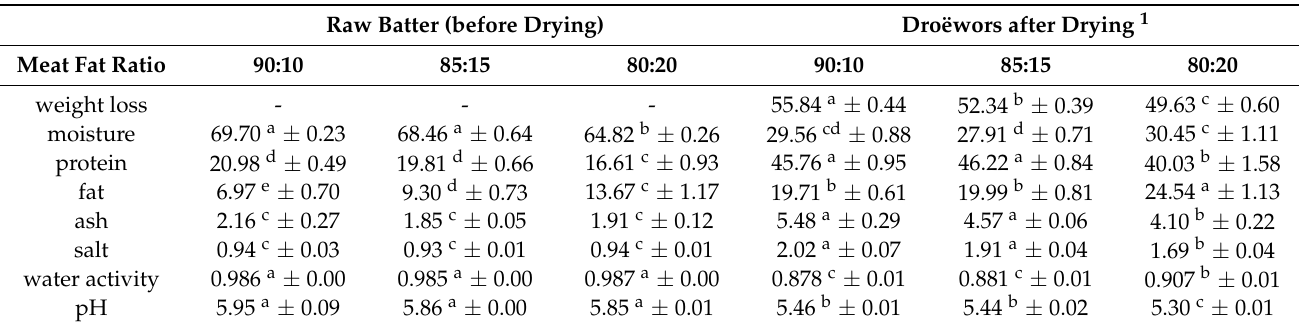
Table 2. Weight loss during drying and physico-chemical properties (mean and standard errors, n = 8) of raw batter and zebra droëwors made with different sheep fat